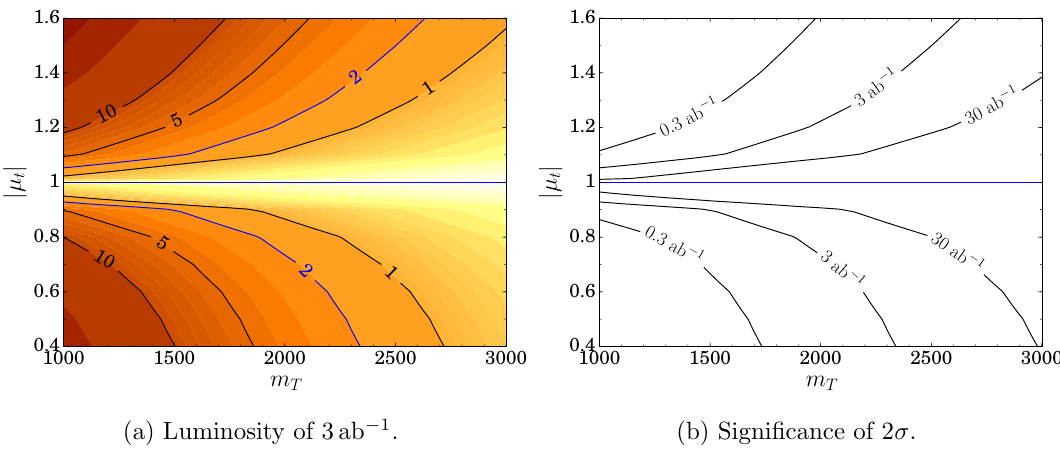
Figure 5. Exclusion limit for unnatural theories de(cid:12)ned by Z ( b + s top partner mass. Based on TTh production at 100 TeV. For a luminosity of 3 ab (cid:0) 1 in (cid:12)gure a and for 0 : 3 ; 3 ; 30 ab (cid:0) 1 and a (cid:12)xed signi(cid:12)cance of 2 (cid:27) in (cid:12)gure b.